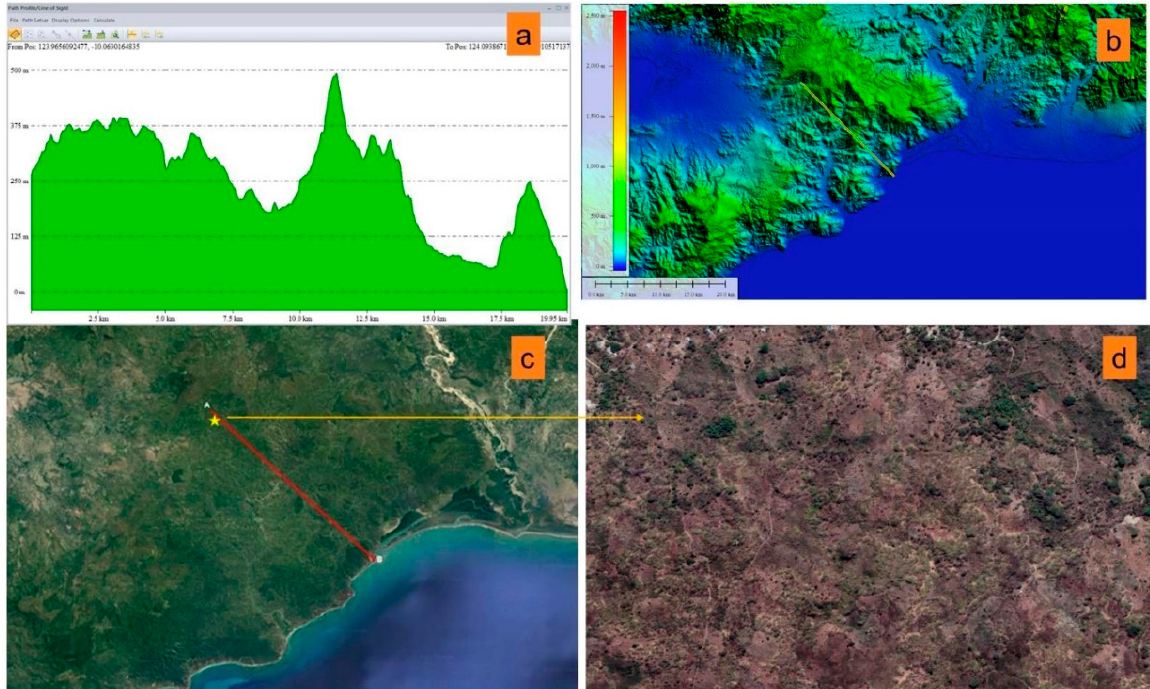
Figure 6. Path profile of global mapper ( a , b ), Mosaic SPOT 6 at a scale of 50,000 ( c ), bush ‐ shrub at a scale of 5000 ( d ). Location in Kupang Regency, East Nusa Tenggara, elevation between 0 and 500 m above sea level, annual rainfall <1500 mm (dry climate).